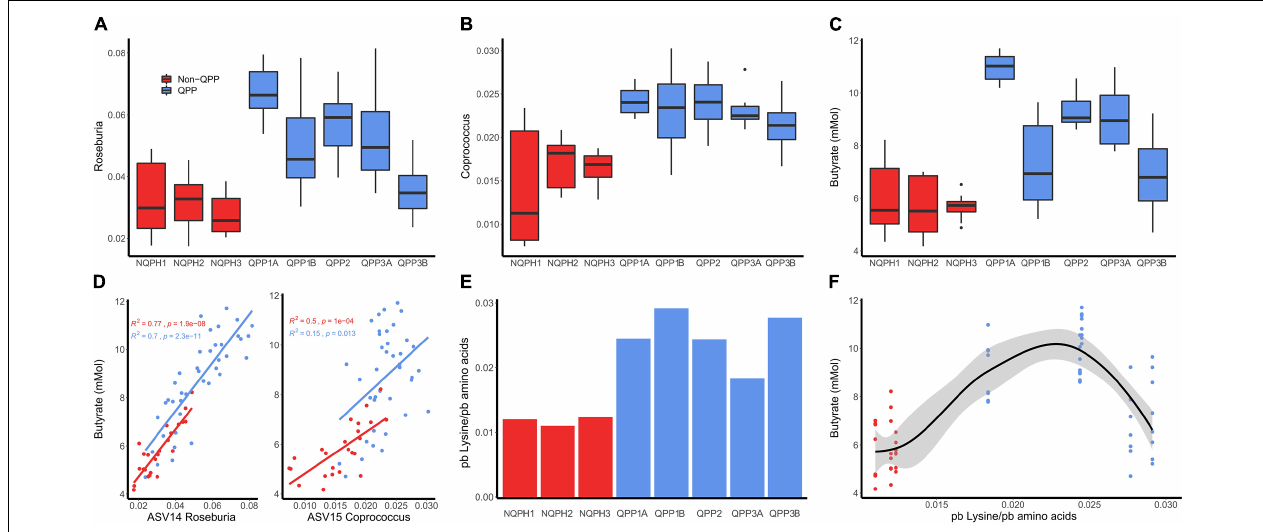
FIGURE 4 | Relative abundances of (A) Roseburia and (B) Coprococcus in the microbiome of subject 1 after treatment of QPP and NQPH pairs. Butyrate concentration was highly correlated with the relative abundance of (C) ASV13 Roseburia and, to a lesser extent and ASV15 Coprococcus (D) . The measured amount of pre-digestion, protein bound lysine (E) is linearly correlated to butyrate concentration (F)